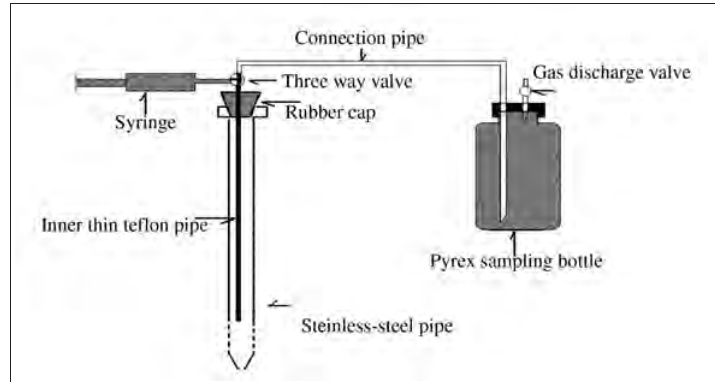
Fig. 3. Schematic representation of the sampling system (Gugliandolo et al. ,